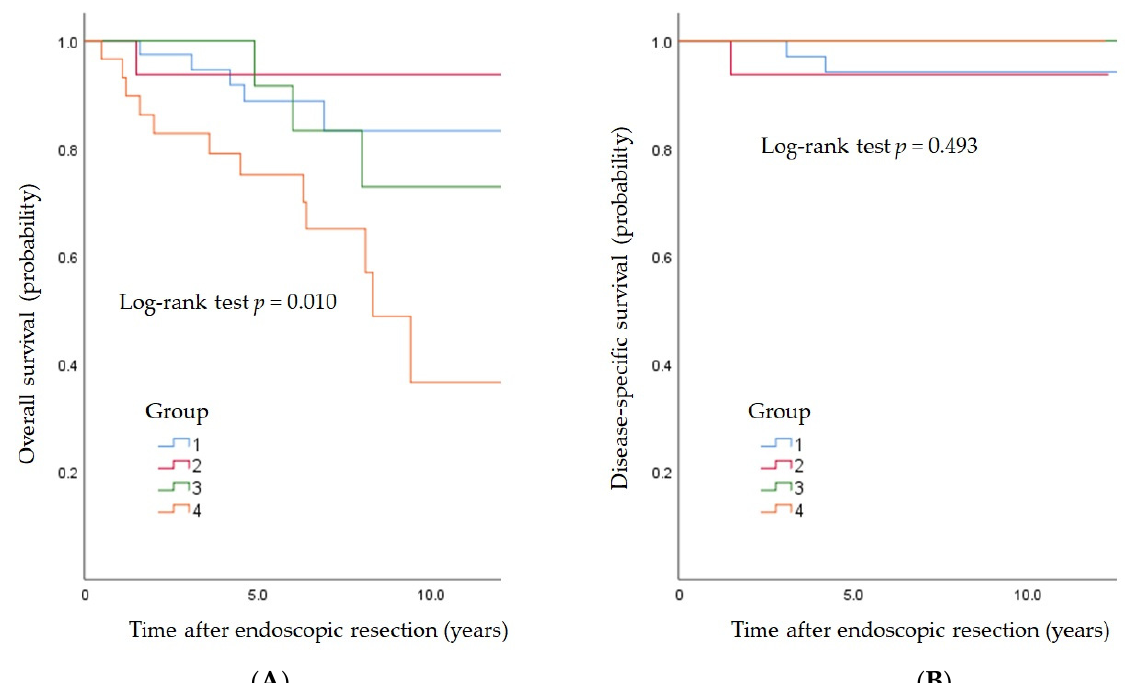
Figure 3. ( A ) The overall survival. The five-year survival rate (SE) in each group was as follows: Group 1, 0.889 (0.053); Group 2, 0.938 (0.061); Group 3, 0.917 (0.080); and Group 4, 0.751 (0.082). The hazard ratio (95% CI) of each group compared to Group 1 was as follows: Group 2, 0.64 (0.03–3.96); Group 3, 1.36 (0.28–5.59); Group 4, 3.95 (1.48–12.38). ( B ) The disease-specific survival. The five-year, disease-specific survival (SE) in each group was as follows: Group 1, 0.942 (0.040); Group 2, 0.938 (0.061); Group 3, 1.000 (0.000); and Group 4, 1.000 (0.000). The hazard ratio (95% CI) of each group compared to Group 1 was as follows: Group 2, 1.48 (0.07–15.53); Group 3, 0.00 (0.00–4.58); Group 4, 0.00